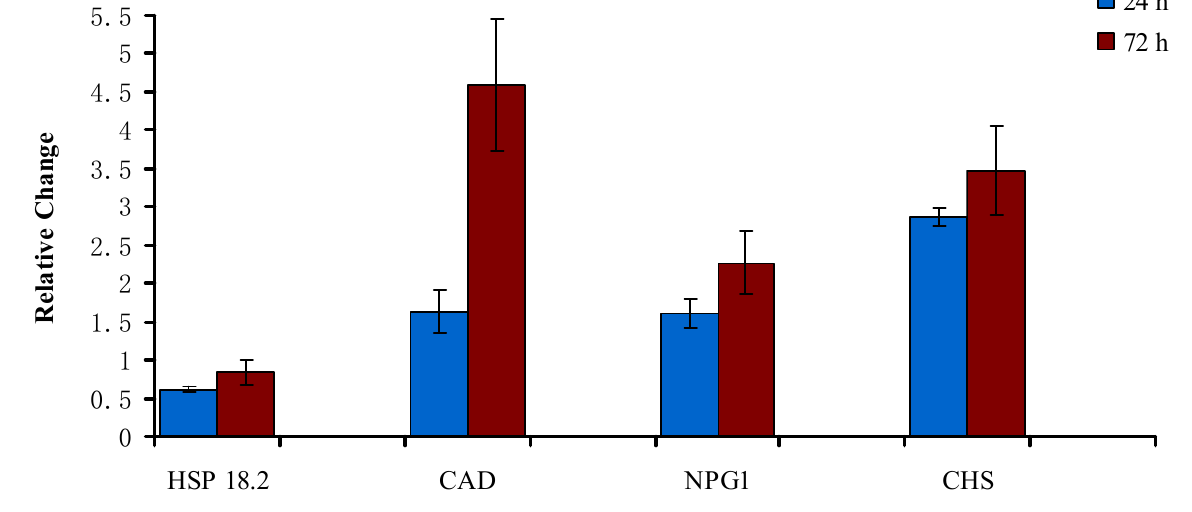
Figure 2. Quantitative real-time PCR of transcripts that were differentially expressed at 24 h and 72 h from PWN-inoculated Masson pine trees. The change is expressed as the relative difference in gene expression between the PWN-inoculated sample and the water-inoculated